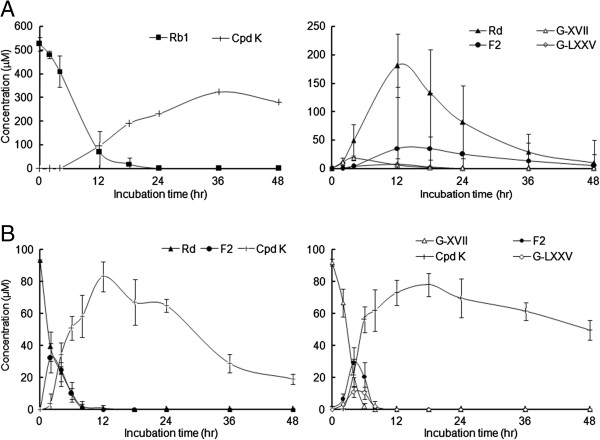
Time-courses of the elimination and metabolite formations of (A) ginsenoside Rb1, and (B) Rd (solid line) and G-XVII (dotted line) in human gut bacteria.